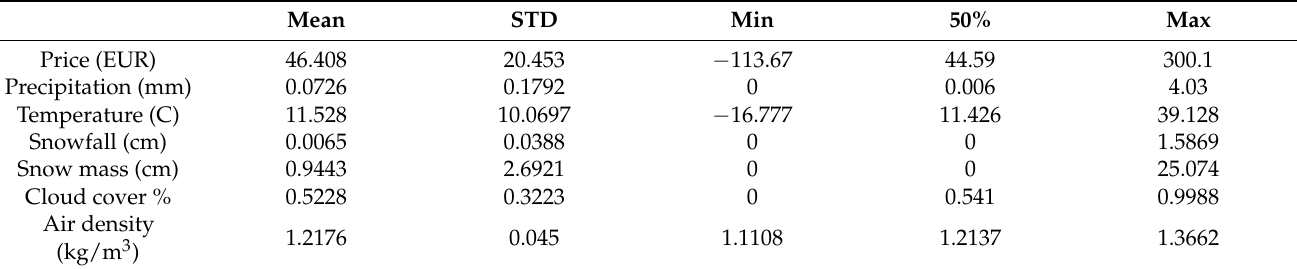
Table 1. HUPX dataset descriptive statistics.